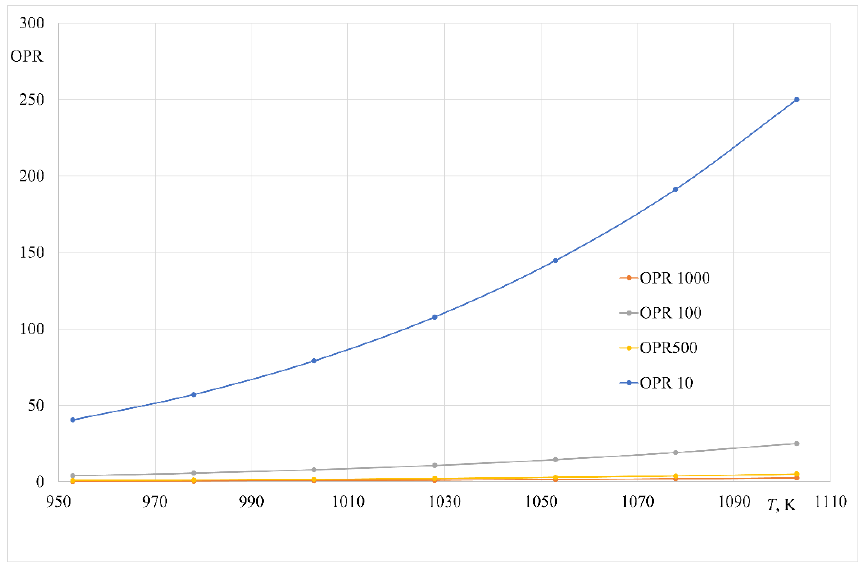
Figure 13. Change in the value of the OPR coefficient for different working pressures of the furnace.